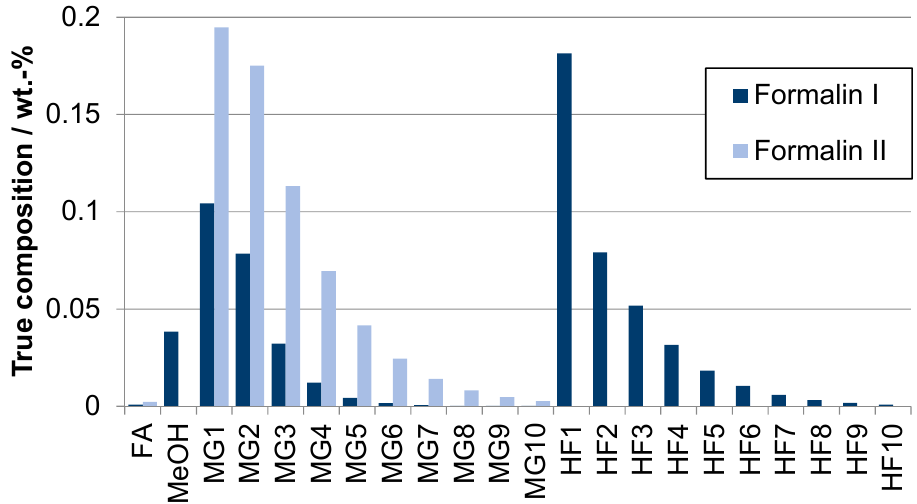
Figure 12. True composition in weight as a percentage of formalin I and formalin II at 60 °C and 1 bar.